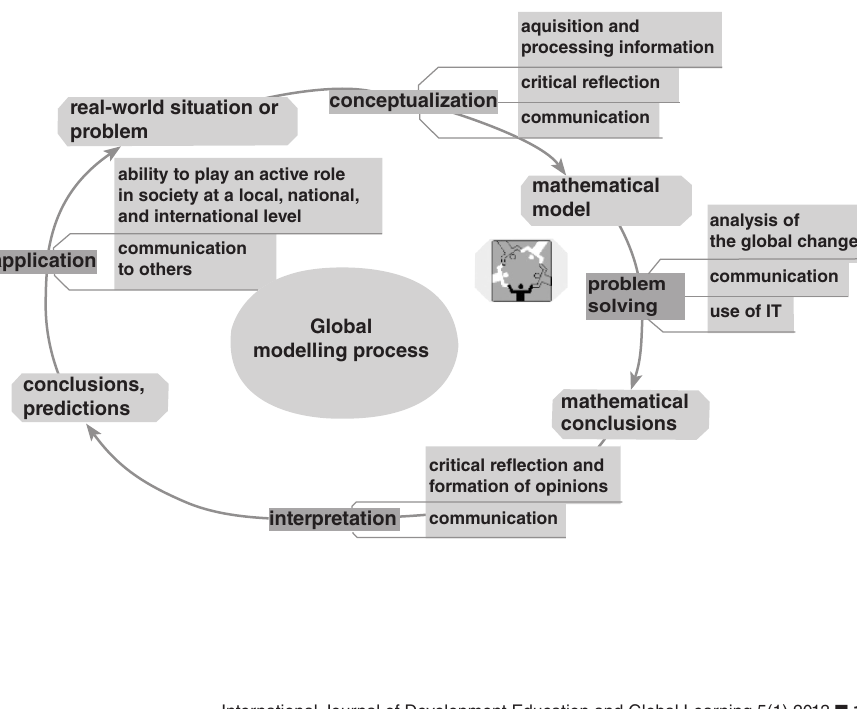
Figure 1: A ‘global modelling process’ integrating relevant global skills and